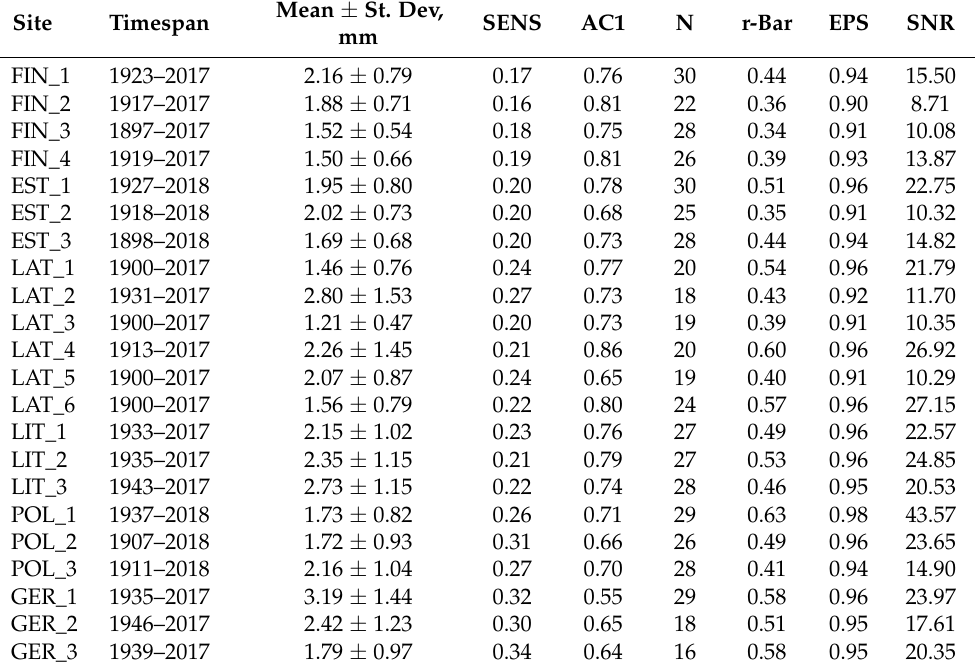
Table 3. General statistics for the datasets of crossdated tree-ring width time series of the stands of Norway spruce from the Eastern Baltic region for the 1954–2017 period. SENS—mean sensitivity, AC1—first-order autocorrelation, N—number of crossdated time series, r-bar—mean interseries correlation, EPS—expressed population signal, SNR—signal to noise